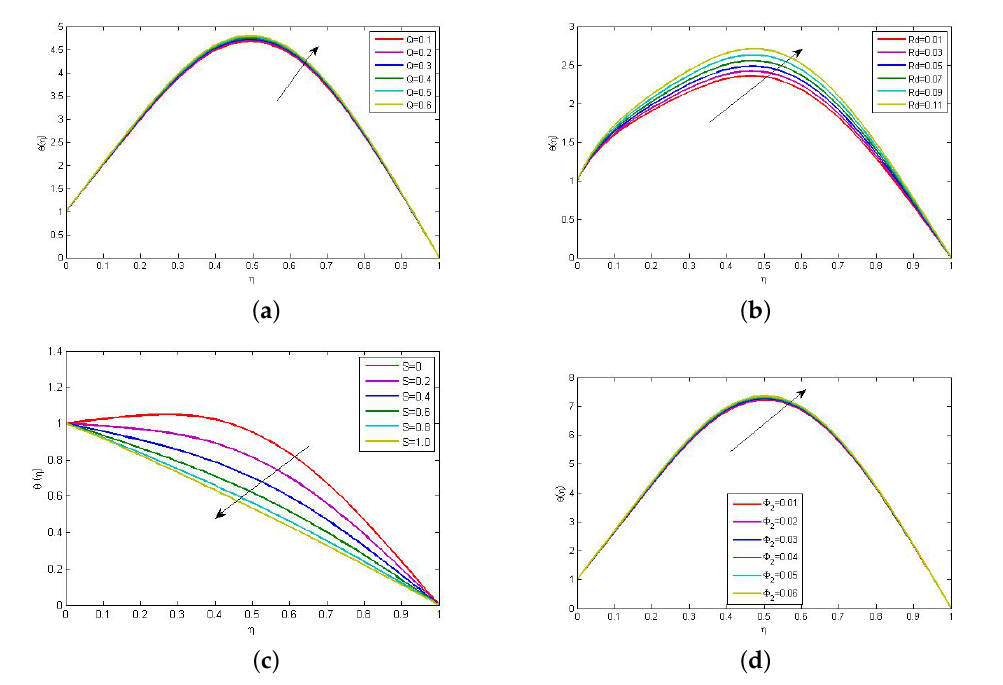
Figure 8. Influence of ( a ) Q , ( b ) Rd ( c ) S and ( d ) φ 2 on Θ ( η ) . Table 3 shows the variation of C f x Re 0.5